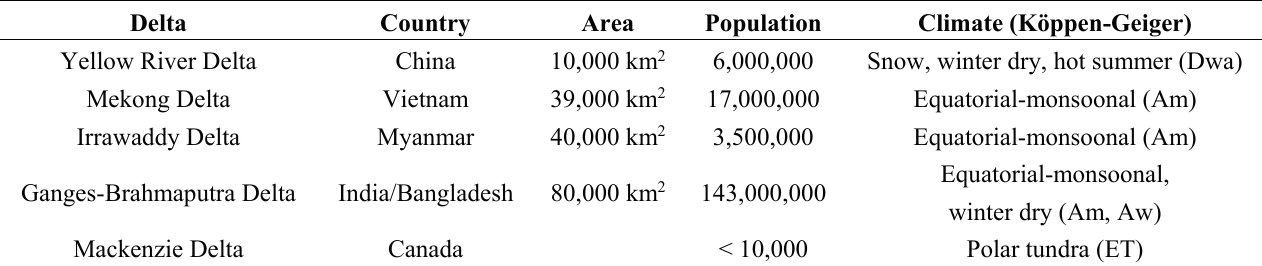
Table 1. Overview of the five river delta areas addressed in this